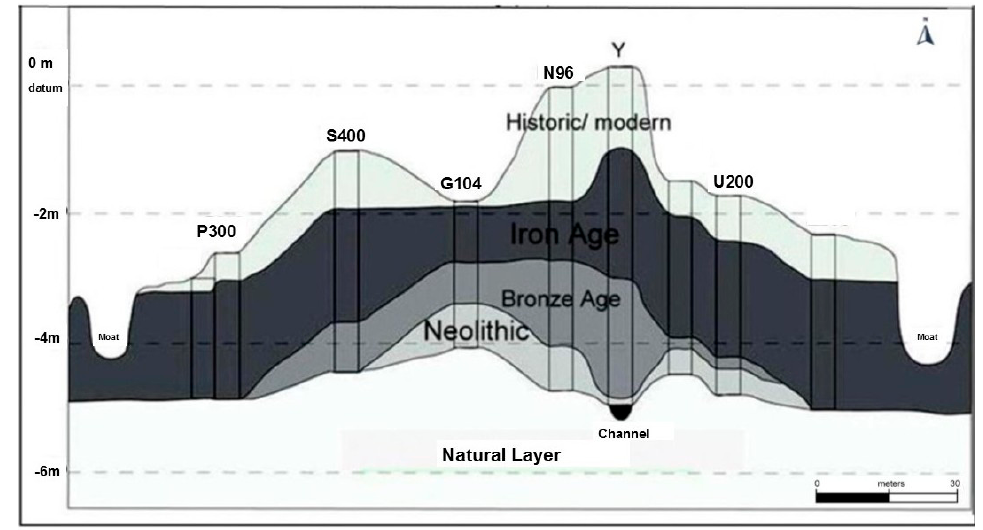
Figure 6. Basic stratigraphic profile of Ban Non Wat from west to east indicating the distribution of the settlements in different periods (image from Nigel Chang).